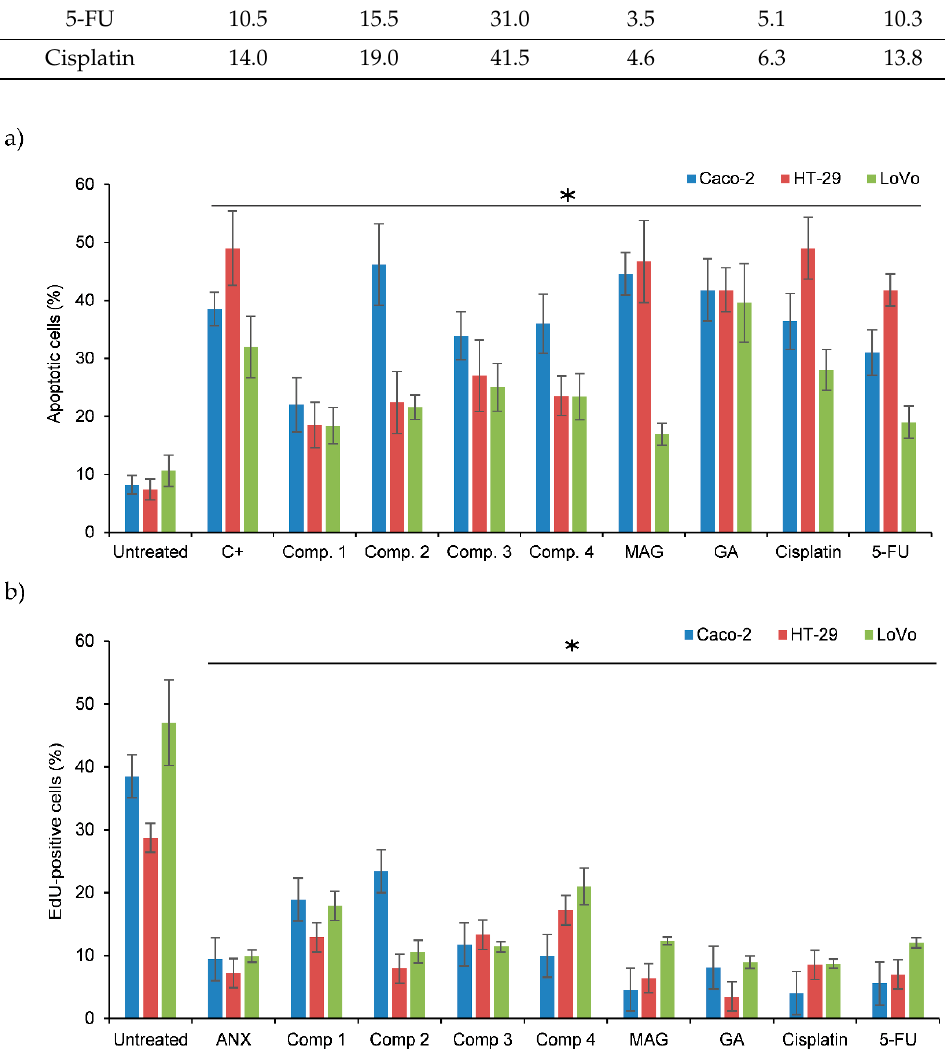
Figure 1. Antiproliferative and proapoptotic potential of xanthone derivatives. ( a ) Proliferation of xanthone-treated colon cancer cells. ( b ) Results of the microscopic evaluation of apoptosis and necrosis in the xanthone-treated cell cultures. Columns present the mean values (+/ − S. D.) of dead cell numbers determined in three independent experiments, each in triplicate. C+: mixture of etoposide, camptothecin, and dexamethasone. * indicates a significant difference ( p < 0.05) vs. untreated controls.